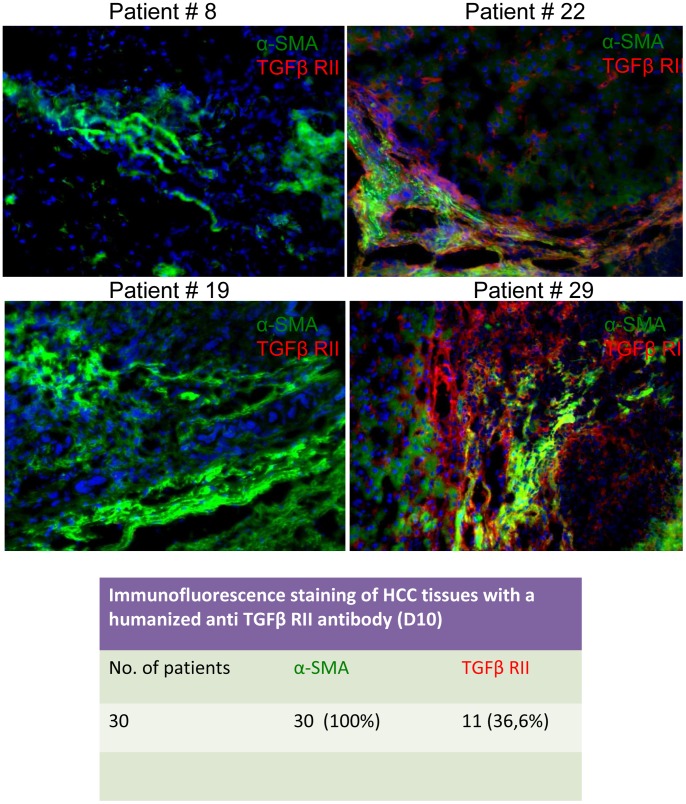
Immunofluorescence staining of TGF-β receptor II in frozen HCC tissues.Tissues from 30 patients with HCC were stained using D10, a fully humanized monoclonal antibody directed against TGF-β receptor II (red) and alpha smooth muscle actin with the monoclonal antibody clone 1A4 (green). In 11 out of 30 HCC tissues (36.6%) positivity for TGF-β receptor II was obtained; representative cases of TGF-β receptor II-positive (patient #22 and #29) or -negative (patients #8 and #19) tissues are shown.